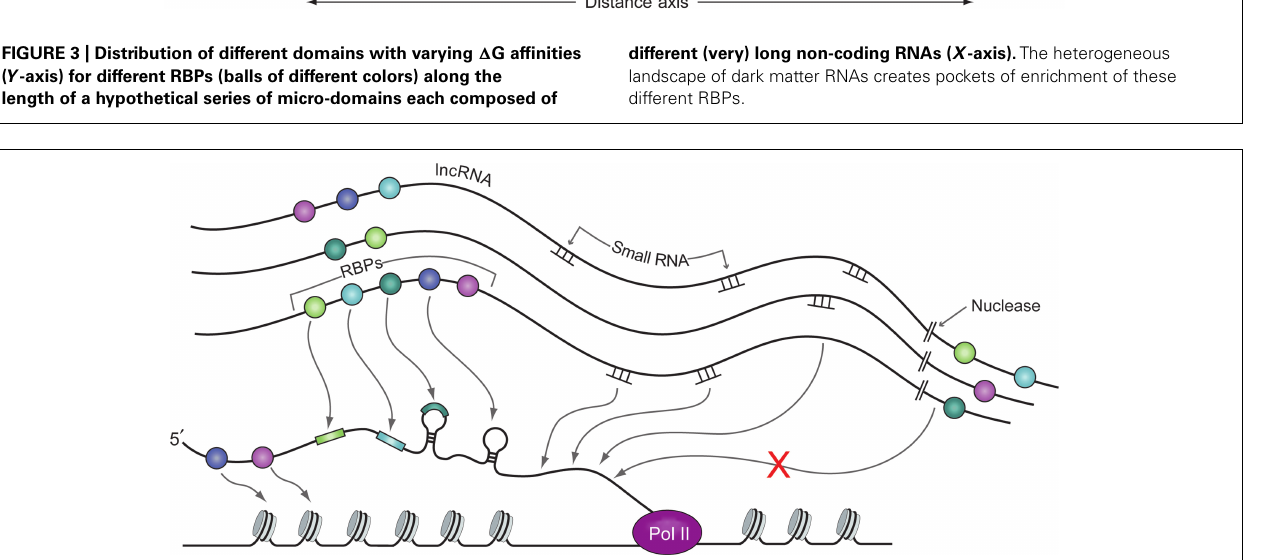
nascent strand that possess specific motifs for the former. Nuclease action cleaves the non-coding RNA template and thus changes the structure of the scaffold complex.This in turn can change the kinetics of the interaction between the RBPs and the small RNAs bound to it and the sequence of their presentation and interaction with the nascent strand of